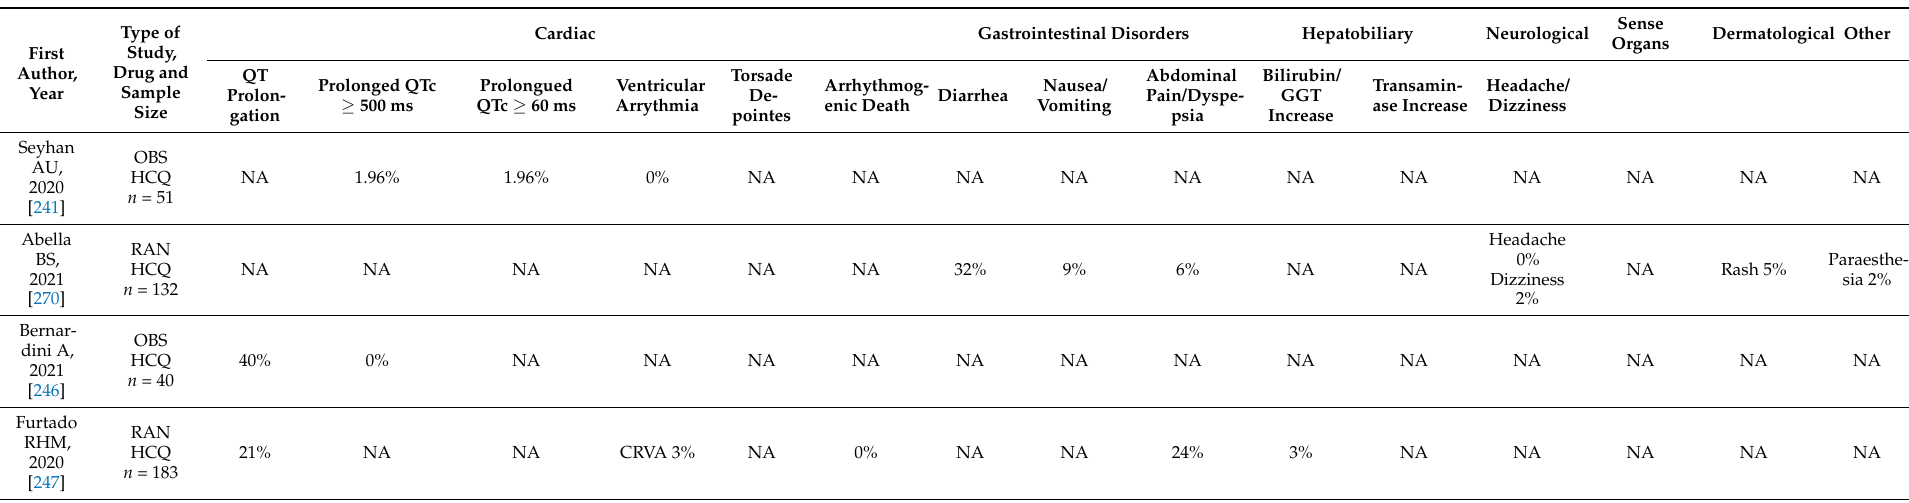
Table 7. Frequency of adverse effects of CQ or HCQ alone when treating COVID-19 reported in observational and randomised